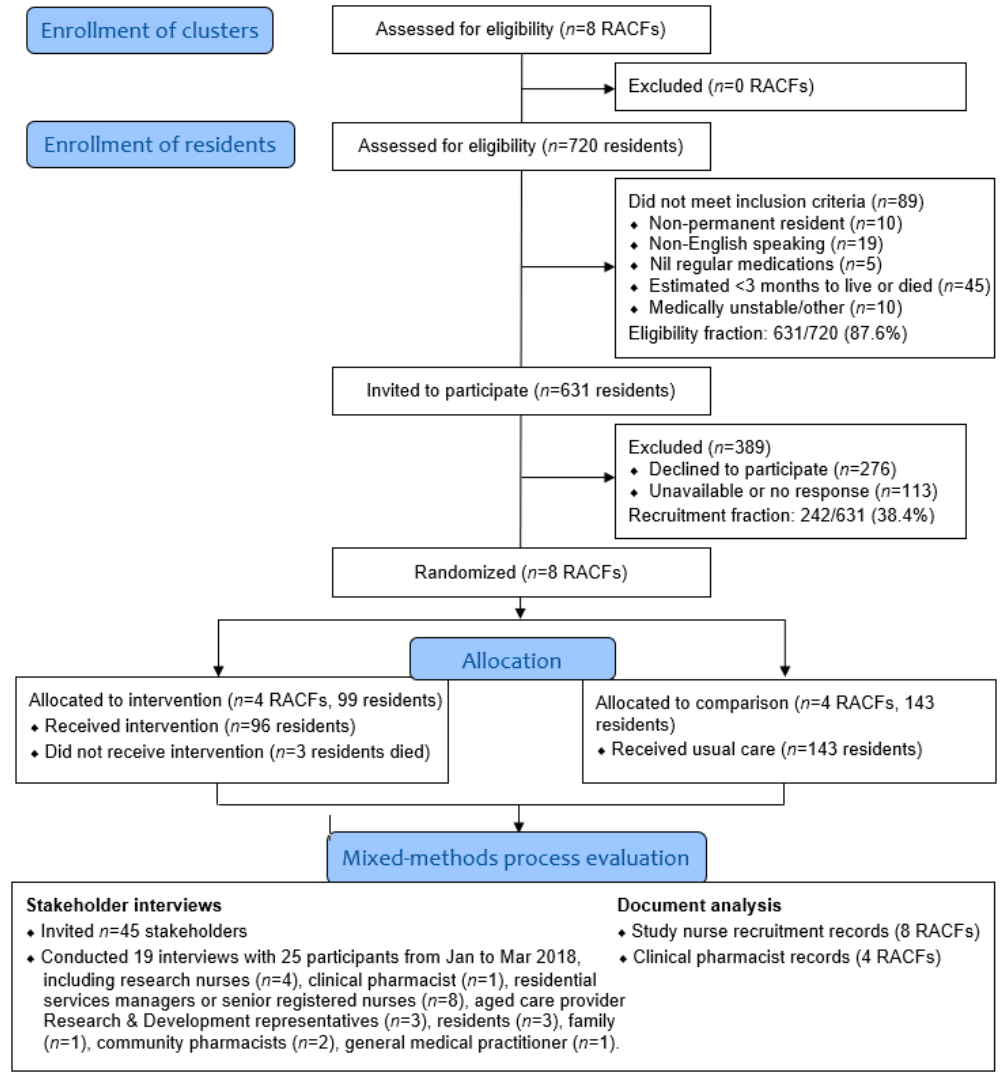
Figure 1. Study flow diagram describing eligibility and recruitment for the SIMPLER study at the cluster and individual resident levels.